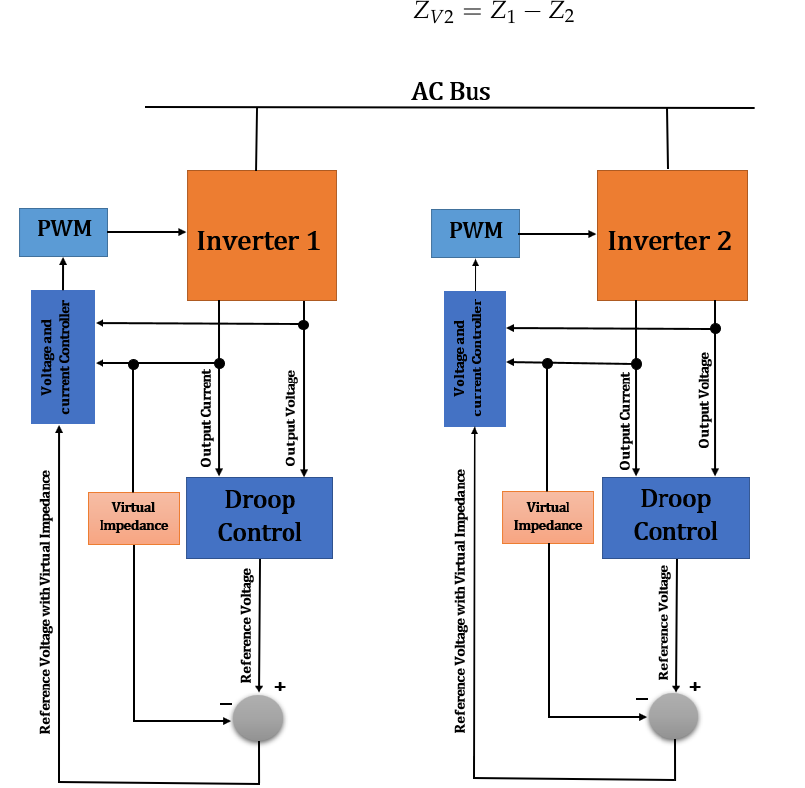
Figure 5. Virtual impedance droop control of parallel inverters in AC microgrid.